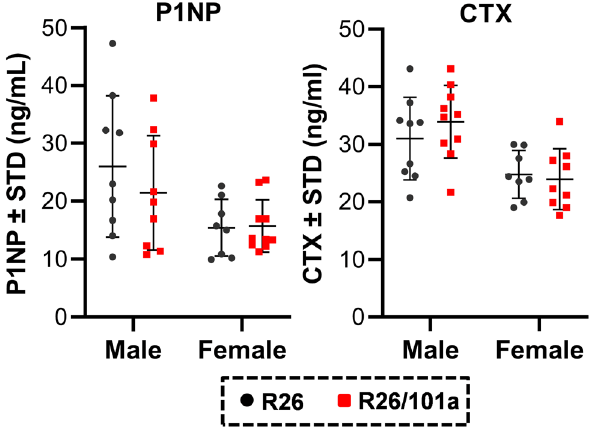
Figure 10. Circulating bone marker levels are not altered by miR-101a over-expression male and female mice. Terminal serum samples were collected from male and female R26 control and miR-101a over-expressing (R26/101a) mice treated with doxycycline from inception to sacrifice (8 weeks). Circulating levels of P1NP and CTX were assessed by commercial ELISA kits.